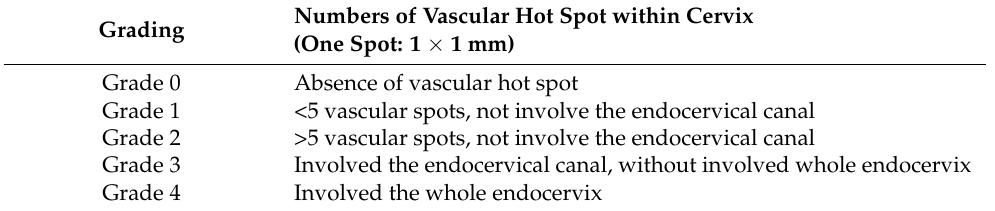
Table 2. Visual vascular hotspot grading